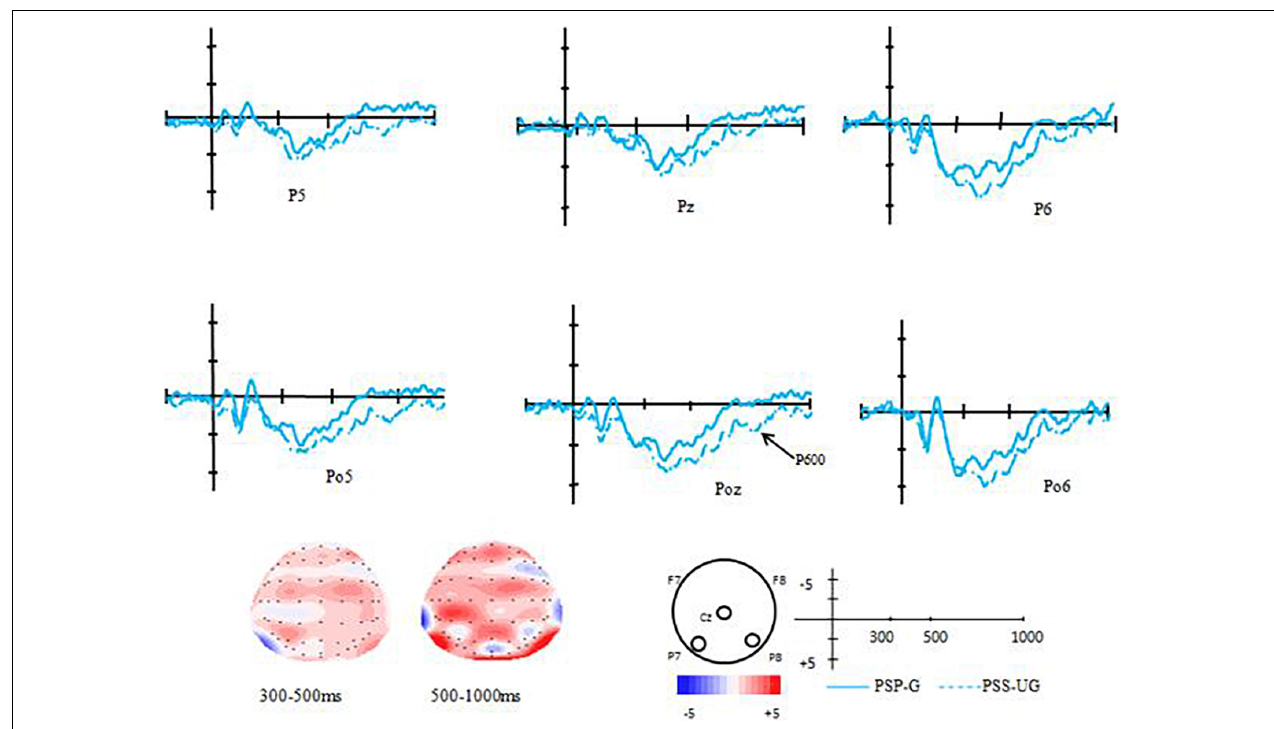
FIGURE 1 | Voltage maps and the grand average ERPs of the EG for the difference between correct and violated sentences in the transfer-effect